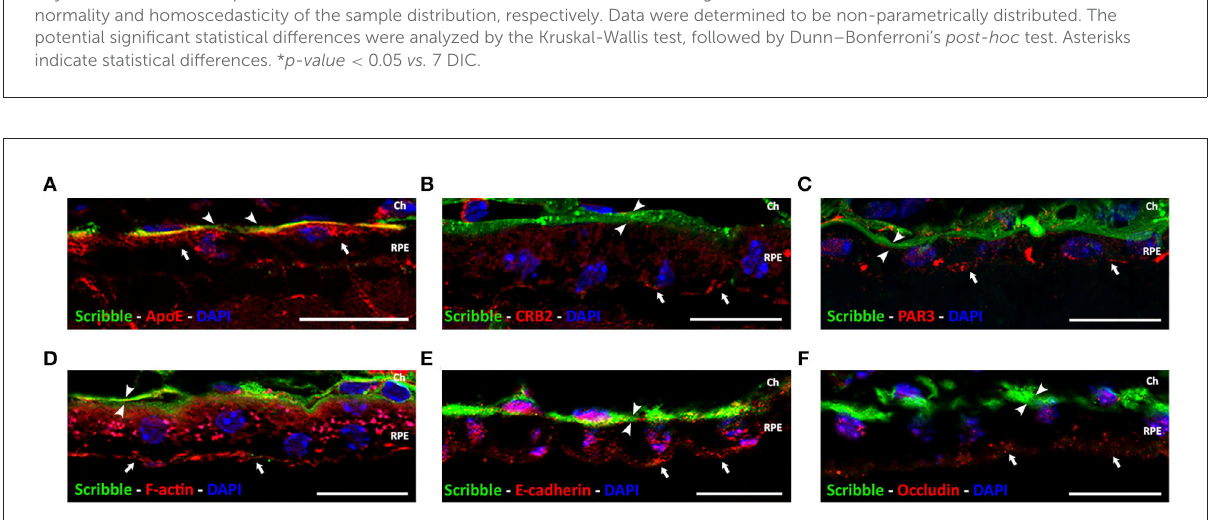
FIGURE2 Localization of Scribble protein in wild-type adult mouse RPE. Double immunolabeling for Scribble (green, arrowheads) and other proteins (red, arrows): carrier protein for lipids, ApoE (A) ; apical polarity proteins CRB2 (B) and PAR3 (C) ; F-actin (D) ; and adherens and tight junctional protein E-cadherin (E) and occludin (F) , respectively. DAPI (in blue): nuclear labeling. Scale bars: 20 µ m. Ch, Choroid; RPE, retinal pigment